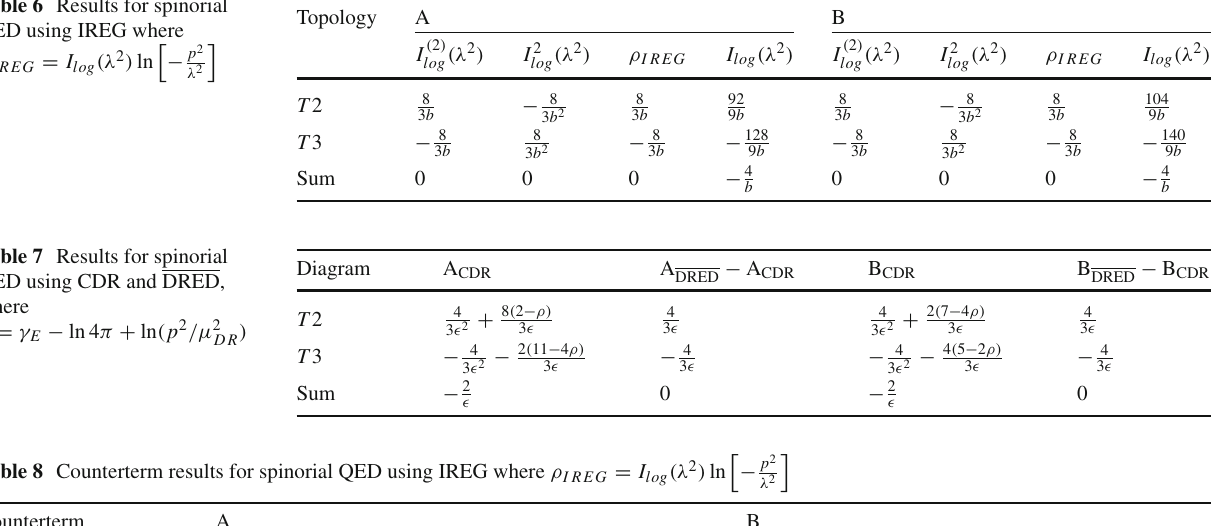
Table 6 Results for spinorial QED using IREG where